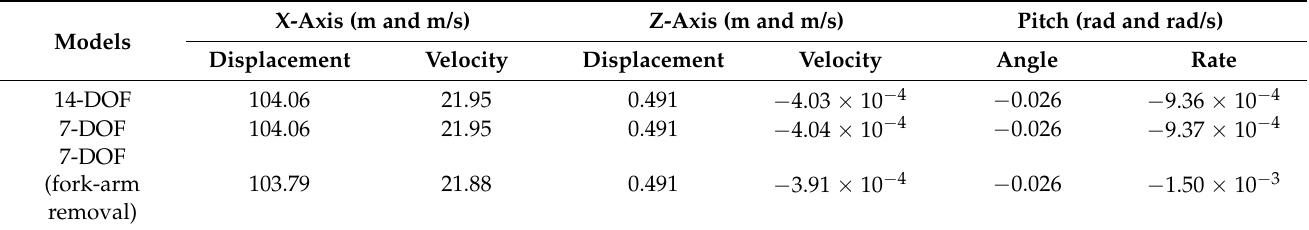
Table 2. The numerical results after 5 s simulation (bumpy road).